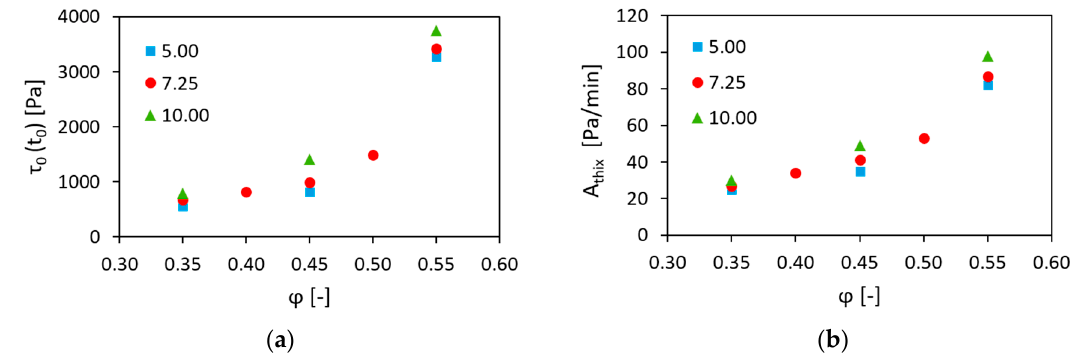
Figure 8. Combined effect of the volume fraction and the surface area of aggregates per unit volume of cement paste on ( a ) the initial SYS and ( b ) the structural build-up rate of concrete.